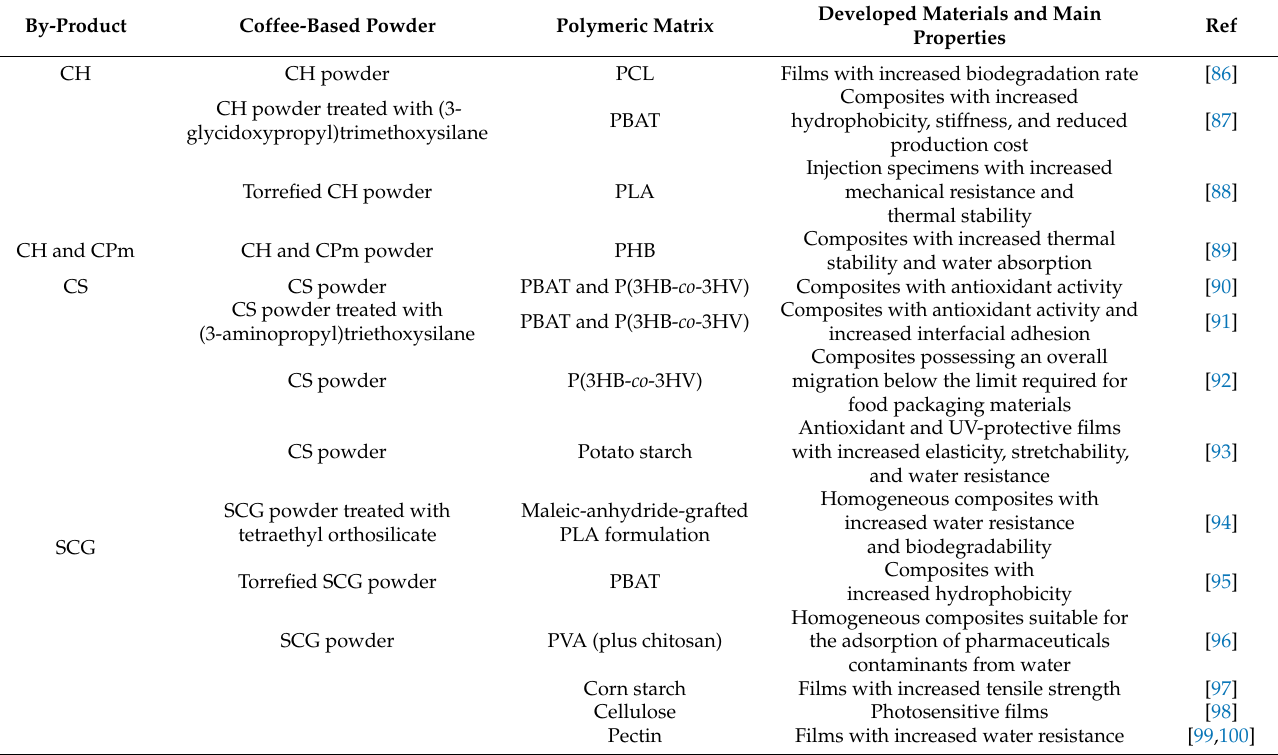
Table 3. Functional additives for biodegradable materials formulations using crude coffee by-products.